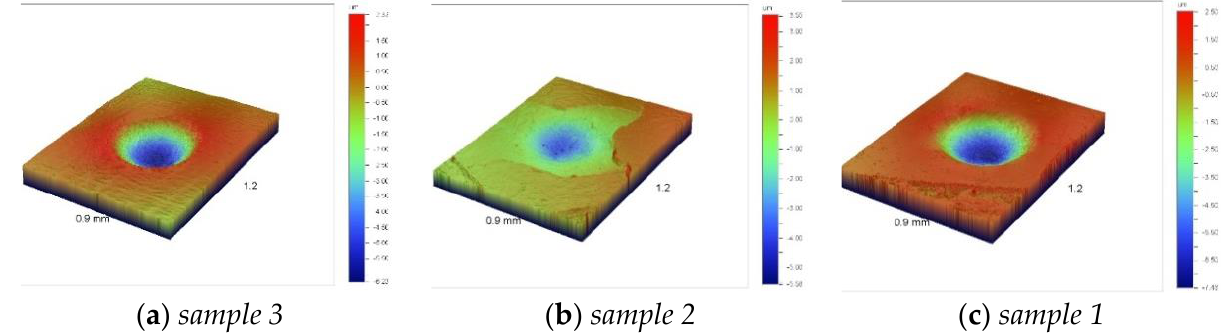
Figure 10. Three-dimensional images of dents on the surface of samples made of low-chromium cast iron, with the test load of 500 N.